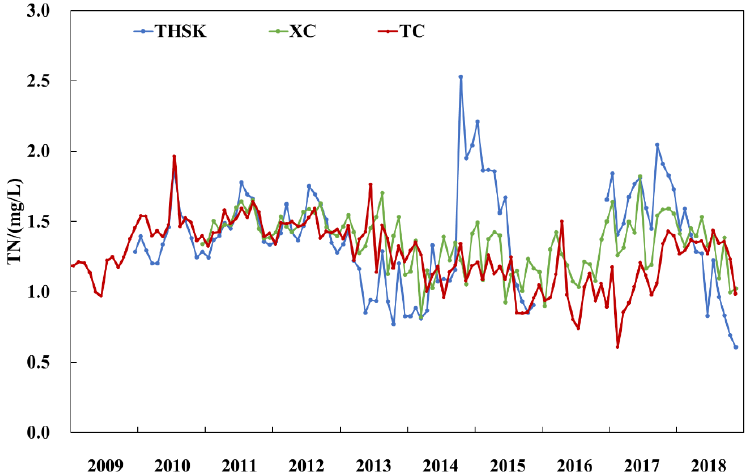
Figure 6. Monthly variation trend of the TN Concentrations in two inflow tributaries (THSK, XC) and Taocha without seasonality (2009 – 2018).